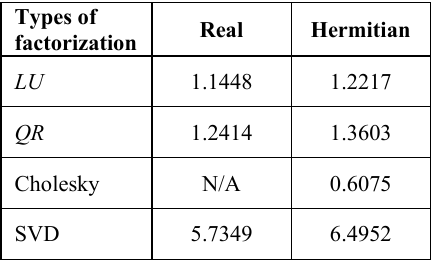
Table 6. Computation time (in second) for 2000 × 2000